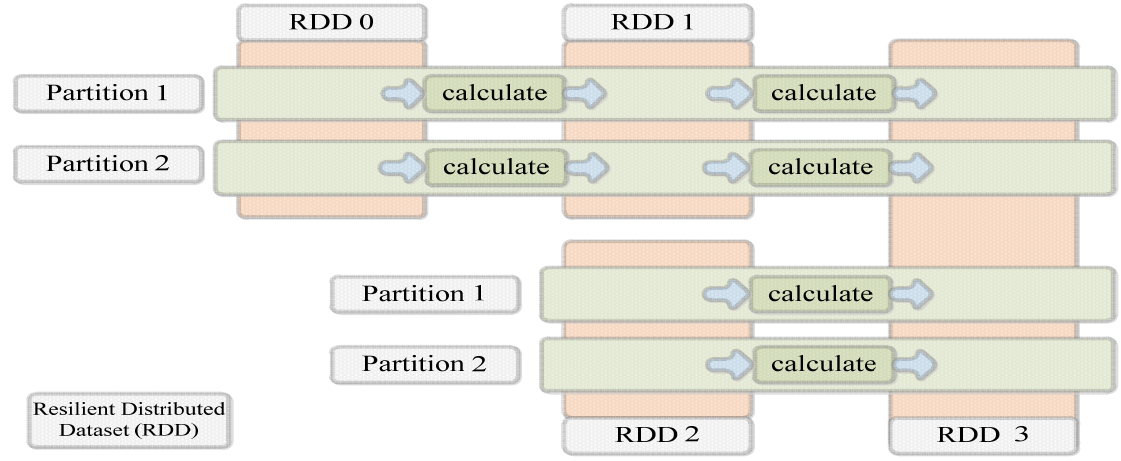
Figure 11. The computing model based on resilient distributed dataset (RDD).